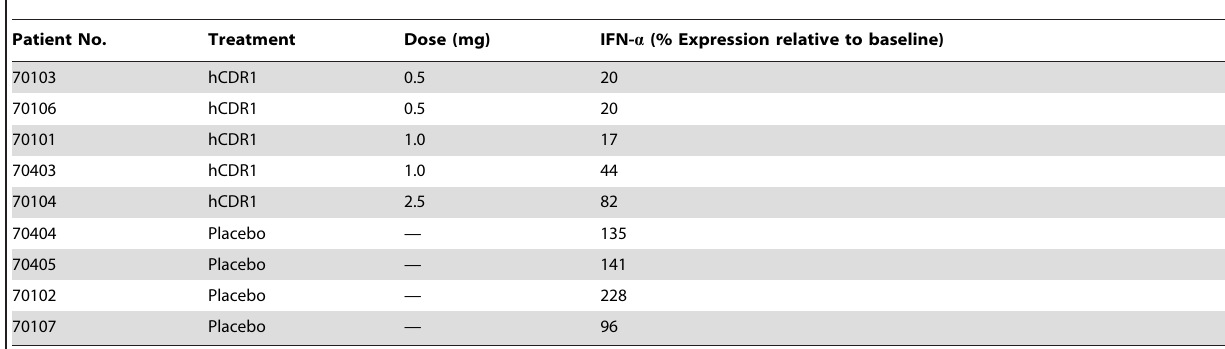
Table 2. The effect of in vivo treatment with hCDR1 on IFN- a gene expression in PBMC of SLE patients.